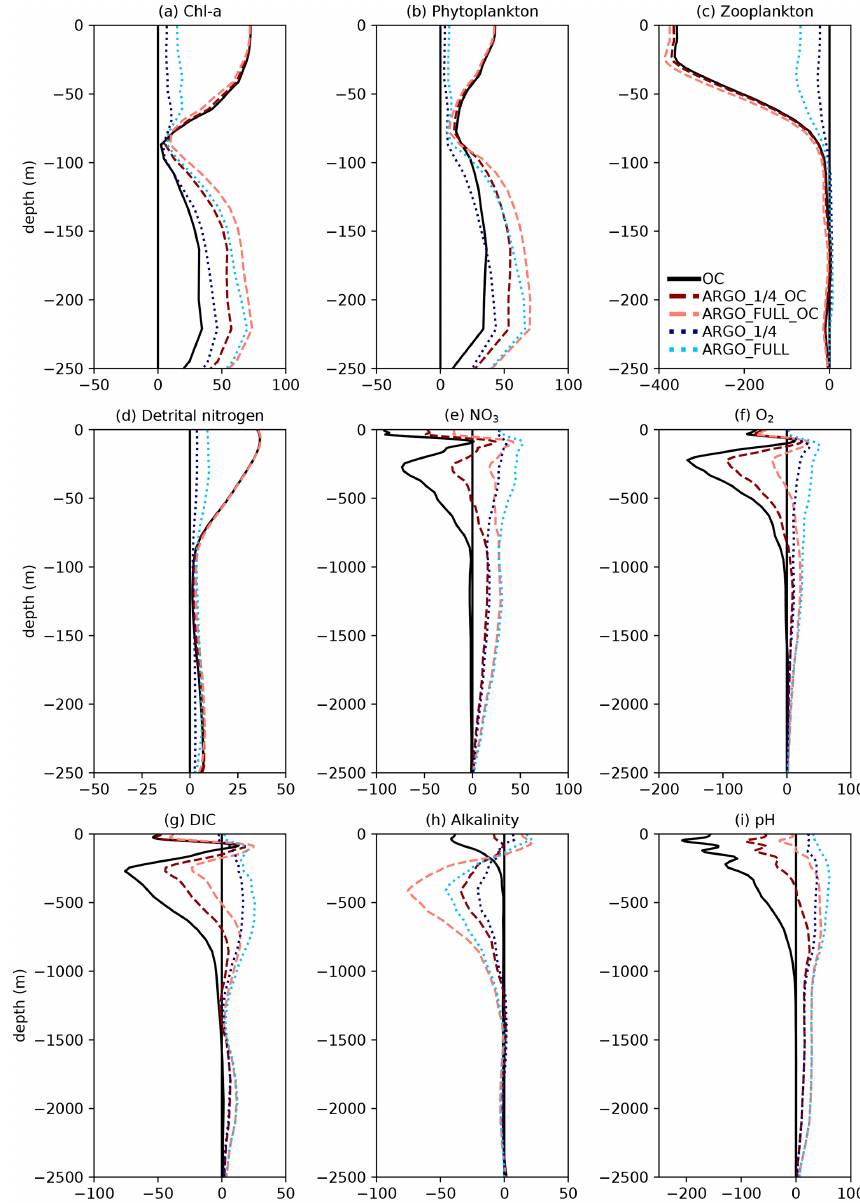
Figure 7. Profiles of global MAE red_% over FREE for December 2009. Note that axis scales differ between